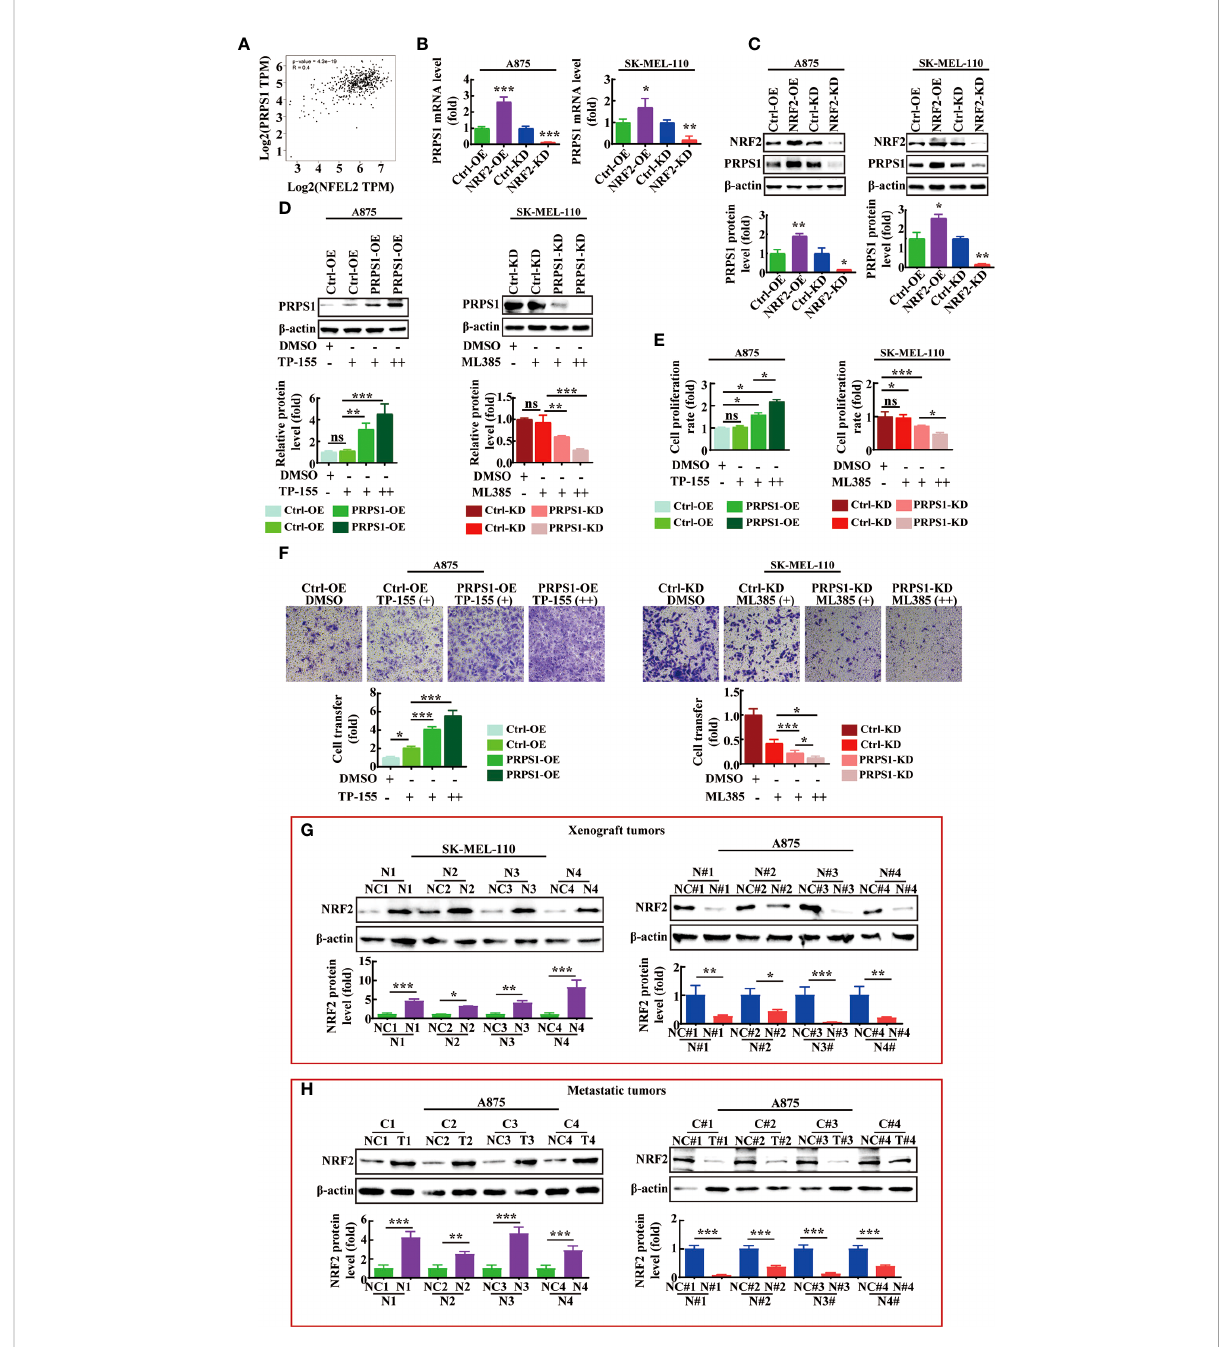
FIGURE 7 NRF2 is positively correlated with PRPS1 expression in melanoma. (A) Spearman correlation analysis of PRPS1 and NRF2 mRNA expression levels was performed in melanoma and normal skin tissues through GEPIA website. (B, C) The mRNA (B) and protein (C) level of PRPS1 were analyzed in the stably NRF2 overexpression or knockdown A875 and SK-MEL-110 and that the control cells. (D – F) The stably PRPS1 overexpression A875 and the control cells were treated with TP-155 (NRF2 activator) for 24h. The stably PRPS1 knockdown SK-MEL-110 and the control cells were incubated with ML385 (NRF2 inhibitor) for 24h. The expression of PRPS1 was detected by using western blot in each group cells (D) . The cell proliferation rate was detected by MTS assay (E) . The rate of migration was measured by transwell assay (F) . TP-155 (+): 0.05uM, TP-155 (++): 0.1uM. ML385 (+): 2.5uM, ML385 (++): 5uM. The cell migration ability was evaluated by transwell migration (F) . TP-155 (+): 10nM, TP-155 (++): 25nM. ML385 (+): 1uM, ML385 (++): 2uM. (G, H) The expression of NRF2 in the xenograft tumors (G) and the lung metastases of nude mice (H) were detected by western blot analysis. Statistical analysis was carried out with unpaired-sample Student ’ s t test or two-way ANOVA. * P < 0.05, ** P < 0.01, *** P < 0.001, ns mean no signi fi cant